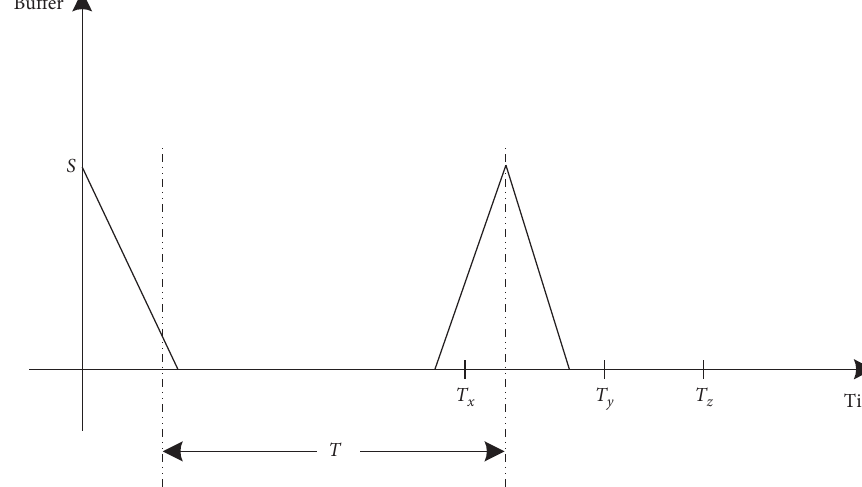
Figure 5: Buffer stock change diagram in a cycle for T